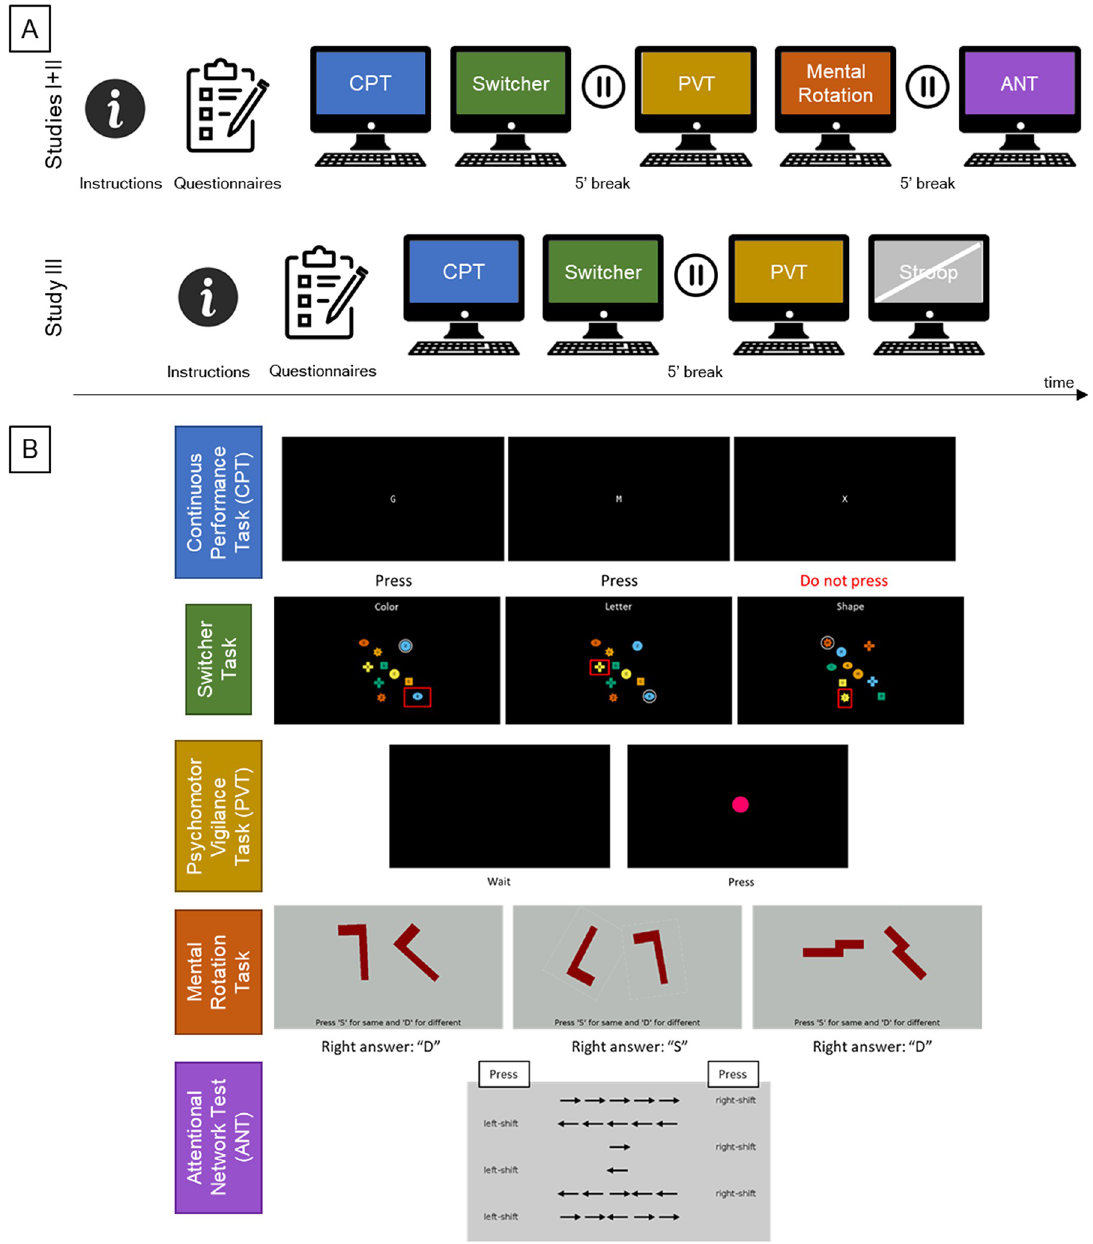
Fig 1. (A) Timeline of the studies. Upon receiving the instructions, participants completed the questionnaires (the Dundee Stress State Questionnaire (DSSQ) and the Cognitive Failures Questionnaire (CFQ) for Study I, only the DSSQ for Study II, and only the Brunel Mood Scale (BRUMS) validated to Brazilian-Portuguese for Study III). Next, participants performed the computerized tests, always in the same order (Continuous Performance Task (CPT), Switcher Task, Psychomotor Vigilance Task (PVT), Mental Rotation, and Attentional Network Test (ANT) for Studies I and II, and CPT, Switcher, PVT, and Stroop Task for Study III. The results for the Stroop Task were not analyzed in this study. Participants took five-minute breaks after conducting two tasks. (B) Screenshots of representative conditions and instructions for the PEBL attention tasks used. Tasks are color-coded as in